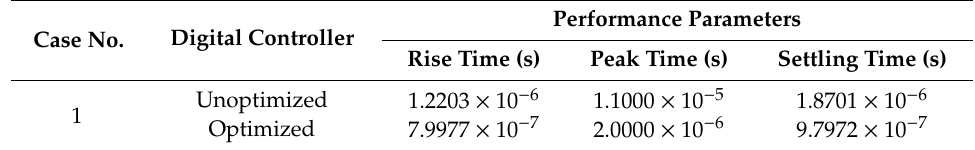
Figure 4. Output voltage response offered by digital compensators. Table 2. Comparison of performance parameters.